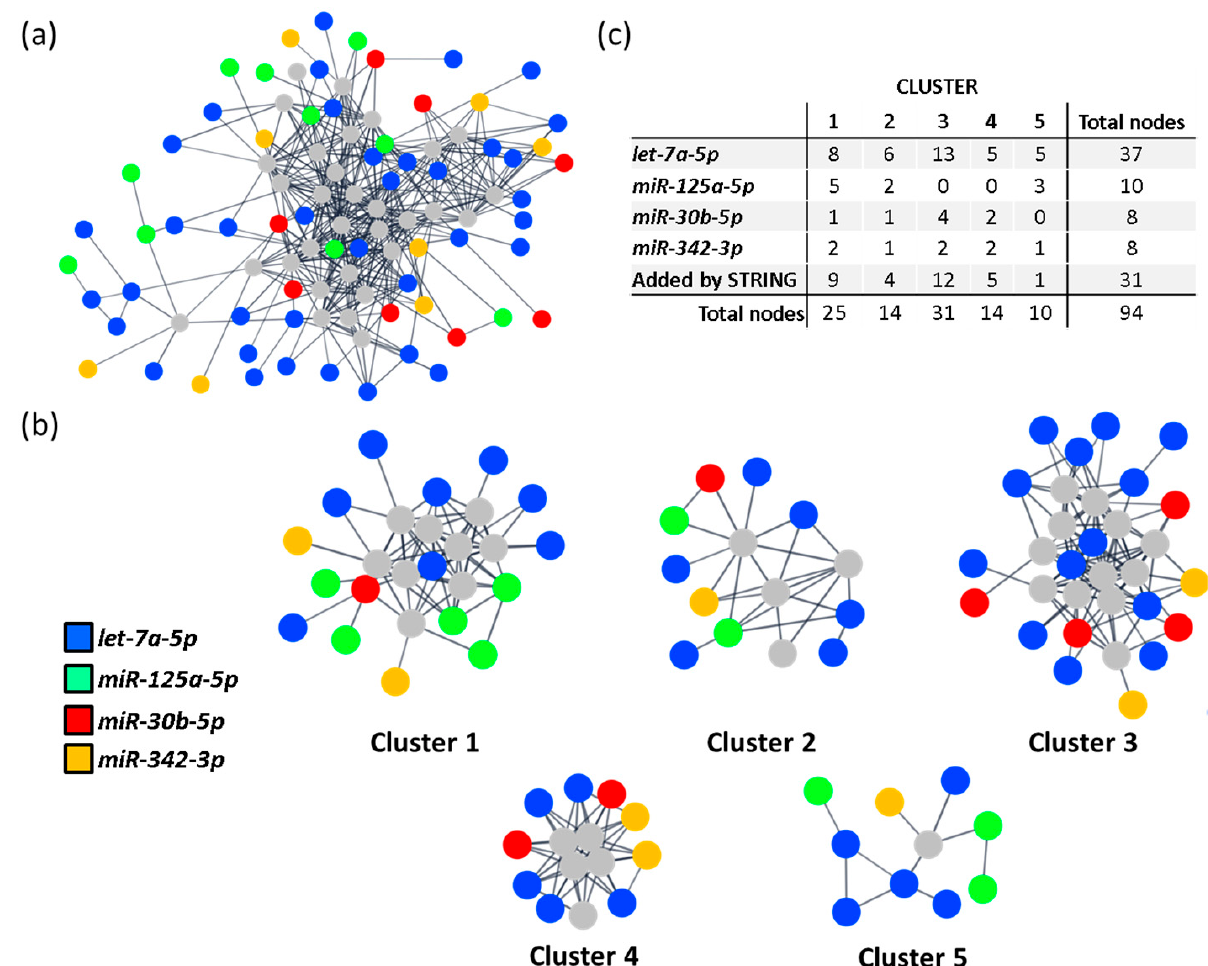
Figure 5. miRNA in DiffmiR clustering and enrichment analysis. ( a ) PPI network of the miRNAs included in C:1–4 but not in C:5+7 of the main PPI network (DiffmiR). Only interactions with a confidence score higher than 0.8 were considered. Node colour represents targeting miRNA. Grey nodes correspond to STRING-added nodes. ( b ) Community clusters identified within the main connected component of the DiffmiR network. Clusters with fewer than five genes were excluded. ( c ) Table with number of target genes regulated by each miRNA, per cluster. C:1–4: miRNAs included in clusters 1–4 of the main PPI network (includes let-7a-5p , miR-107 , miR-125a-5p , miR-139-5p , miR-150-5p , miR-30b-5p and miR-342-3p ); C:5+7: miRNAs included in clusters 5 and 7 of the main PPI network (includes miR-107 , miR-139-5p and miR-150-5p ); DiffmiR: miRNAs included in clusters 1–4 but not in clusters 5 and 7 of the main PPI network (includes let-7a-5p , miR-125a-5p , miR-30b-5p and miR-342-3p ); PPI: protein-protein interaction. As a result, seven clusters were generated from the main connected component of the C:5+7 network (Figure 4b). Of these, five clusters included targets from the three involved miRNAs and were selected for pathway enrichment analysis (Supplemental Table S4).